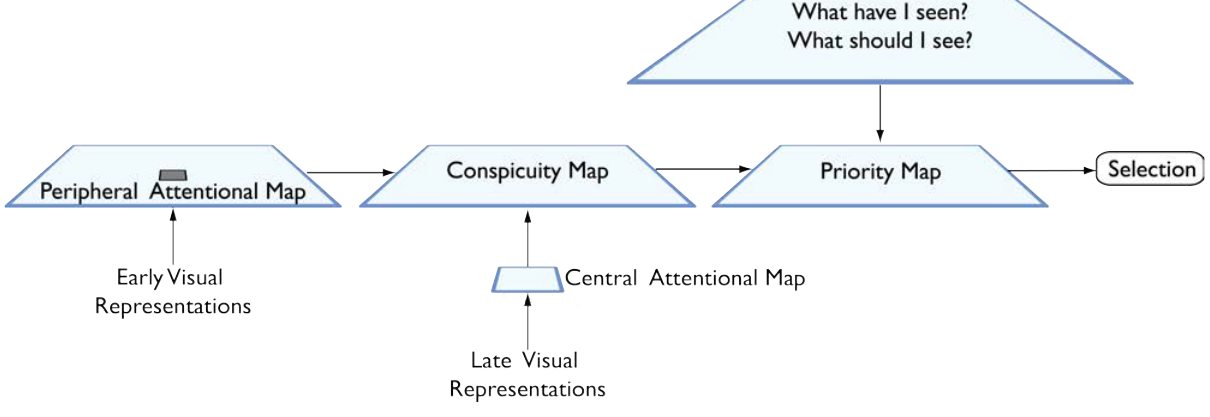
Figure 5. The proposed solution to the boundary problem requires the integration of three representations: early visual con- spicuity based on early visual representations, interpretation based on late visual representations, next fixation history (what have I seen?) and priority (what should I see?). Selection of the next target to fixate is made competitively from this combined representation. The dark rectangle of the Peripheral Attentional Map is the portion of the visual field not represented. The Central Attentional Map is smaller because it represents only the veridical components of late visual representations. It is important to note that this scheme differentiates between the computations that determine what to attend and where to foveate